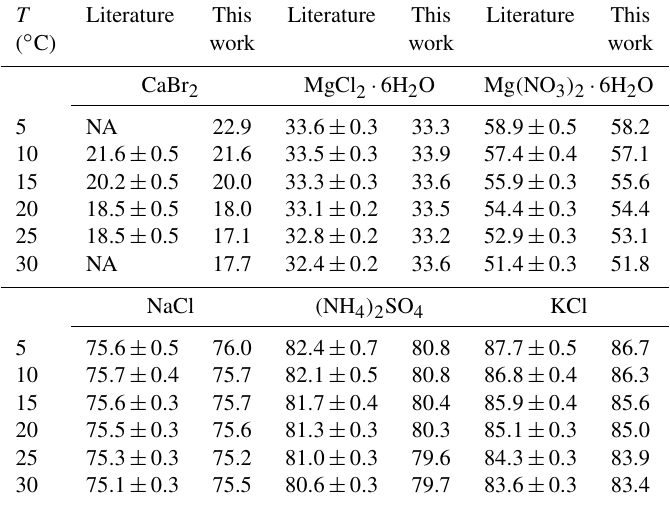
Table 2. Comparison of DRHs measured by our study with those reported in literature (Greenspan, 1977) for CaBr 2 , MgCl 2 · 6H 2 O, Mg ( NO 3 ) 2 · 6H 2 O, NaCl, ( NH 4 ) 2 SO 4 and KCl from 5 to 30 ◦ C. NA: data are not available. The uncertainties for our measured DRH values are estimated to be ± 1%. T Literature This Literature This Literature This ( ◦ C) work work work CaBr 2 MgCl 2 · 6H 2